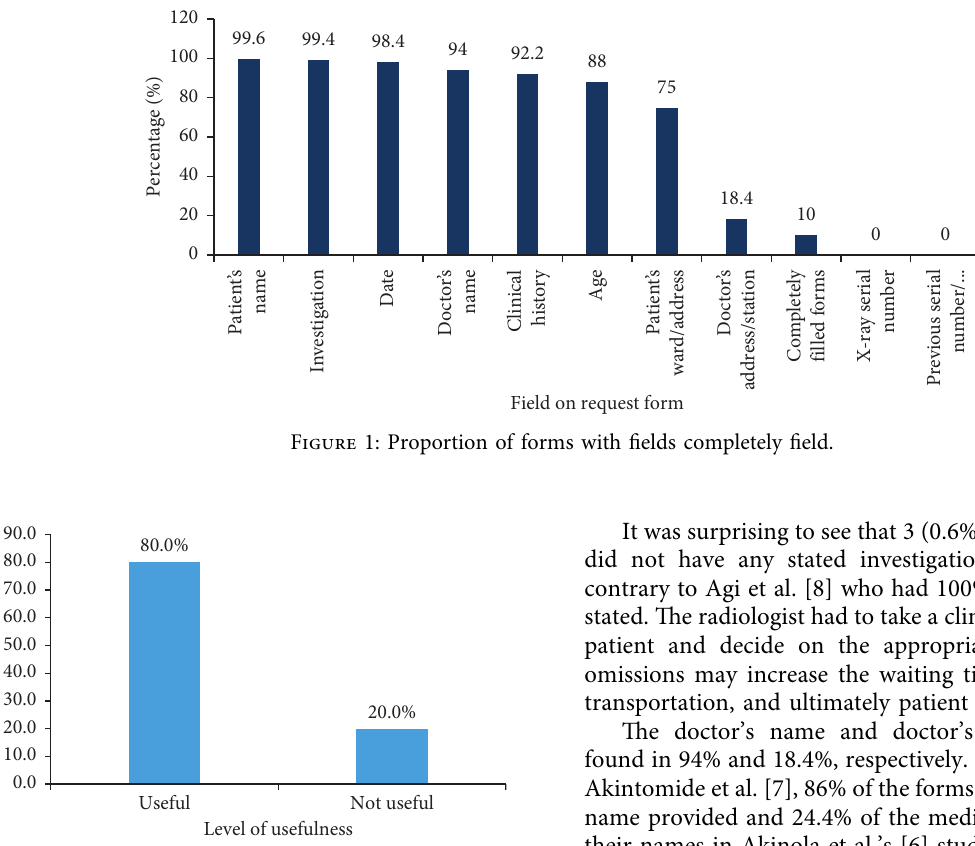
Figure 2: Usefulness of clinical information provided.